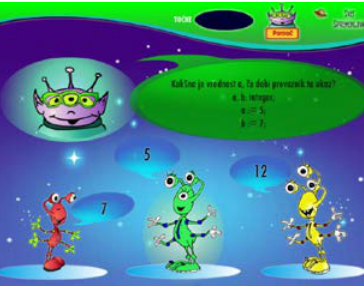
Figure 4. Third game – Acquiring the driving license